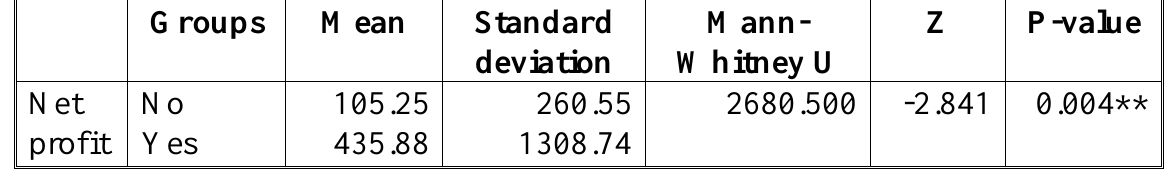
Testing of profitability against a corporate web presence using the Mann-Whitney